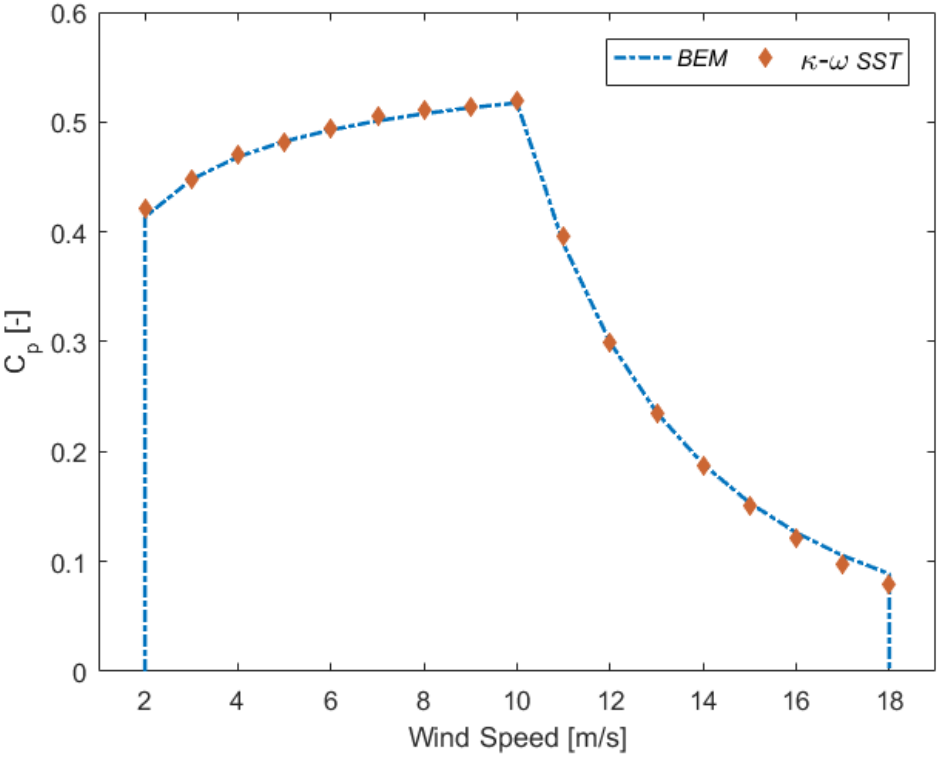
Figure 6. Power coe ffi cient vs. wind speed of the designed blade for an operating range of the Figure 6. Power coefficient vs. wind speed of the designed blade for an operating range of the selected selected sites.